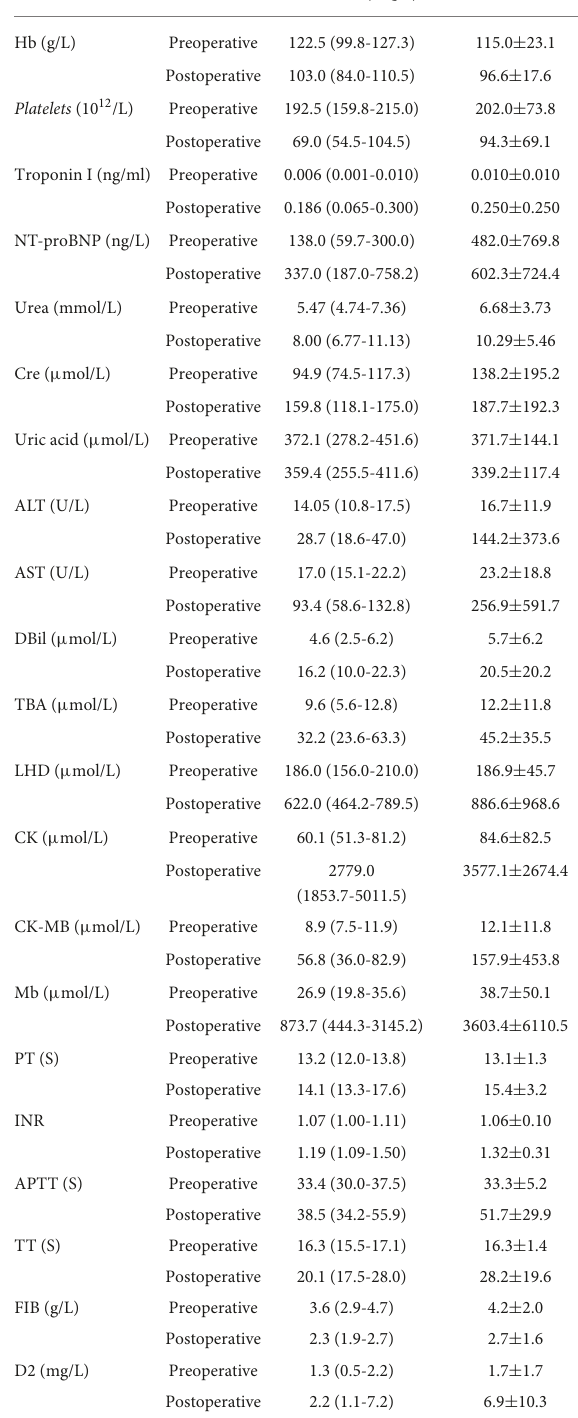
TABLE 5 The preoperative and postoperative laboratory tests